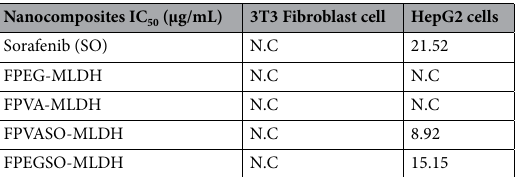
Table 5. The half-maximal inhibitory concentration (IC 50 ) value for sorafenib (SO), FPEG-MLDH, FPVA- MLDH, FPEGSO-MLDH, and FPVASO-MLDH samples tested on 3T3 and HepG2 cell lines. Abbreviation: N.C, No toxicity at 100